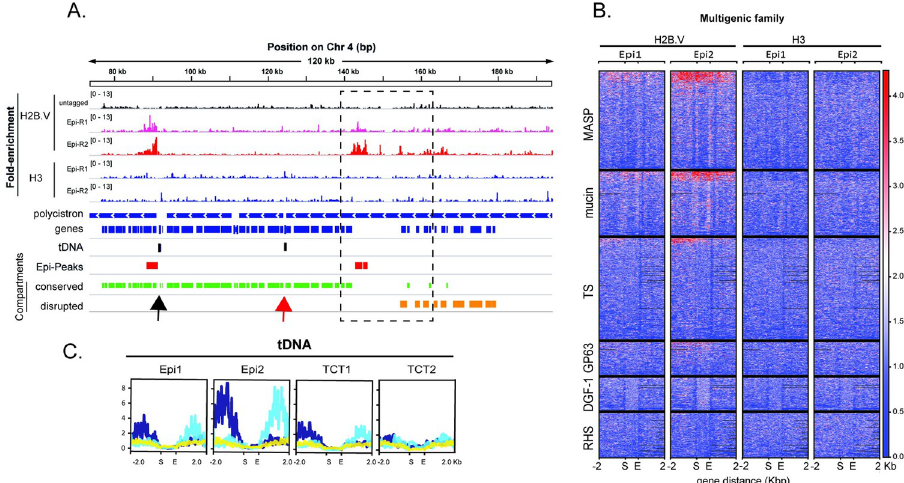
Fig 2. H2B.V enrichment is also found at the border of conserved and disrupted genome compartments and around tDNA loci. A. IGV snapshot of a 120-kb region from Chr 4S highlighting H2B.V enrichment around tDNA loci (black arrow) and between conserved and disrupted genome compartments (rectangle with interrupted lines). Wig files from the ChIP H2B.V/input and ChIP H3/input were obtained by COVERnant. Blue bar arrows indicate the transcription direction in each polycistron. Genes in the same polycistron are stained with the same color. Black and red bars represent respectively, tDNA loci and H2B.V -peaks (fold equal to 4 over the input, Poisson p-value over input required = 1.00e-04) obtained by HOMER in epimastigote form. The conserved and disrupted compartments are represented by green and orange bars, respectively. B. Heatmaps of multigenic family members showing ratios of ChIP H2B.V/input and ChIP H3/input in two epimastigote replicates. Note an enrichment (red) of H2B.V at MASP, mucin and TS genes. C. Summary plot obtained by deepTools of the normalized (ChIP/input) H2B.V reads at tDNA loci and the adjacent 2 kb upstream and downstream regions. The tDNA locus was automatically scaled as indicated (first (S) and last (E) nucleotides of each locus). Normalized data were classified into 3 hierarchical clusters (dark blue– 13 genes, light blue– 11 genes and yellow -31 genes) based on the H2B.V enrichment